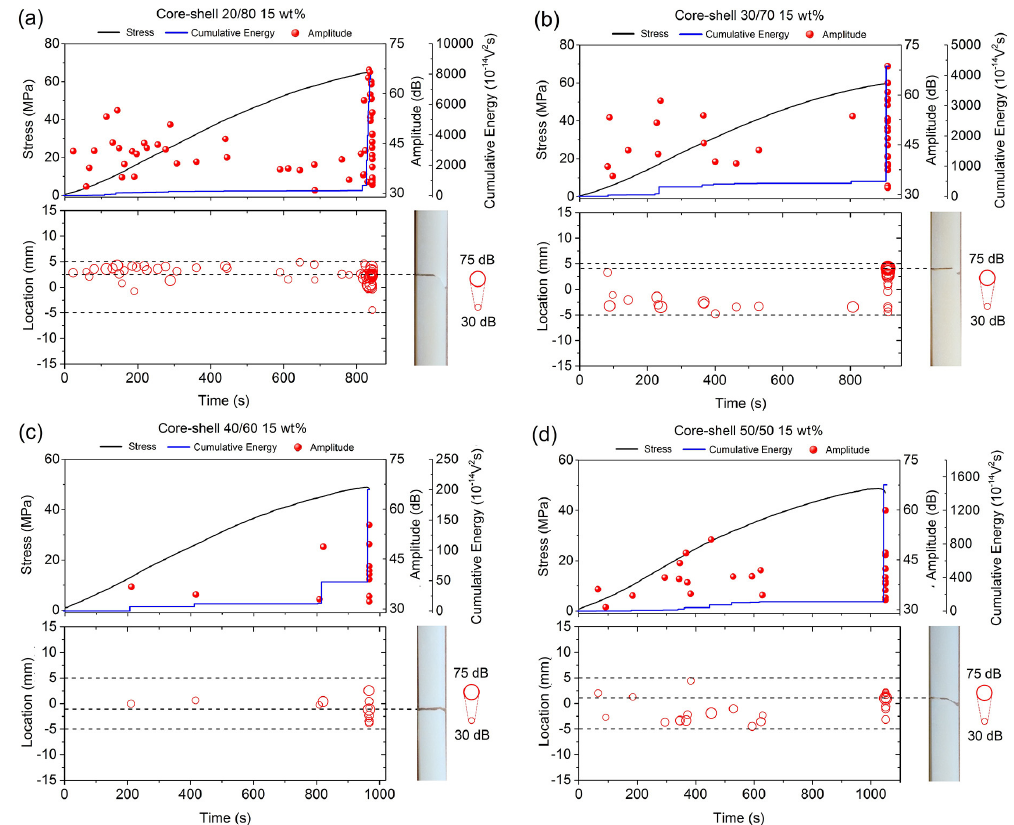
Figure 6. AE signals detected during the four-point bending test in correlation to their respective locations along the specimen surface in the bone cements containing 15 wt % of core-shell nanoparticles ( a ) 20/80, ( b ) 30/70, ( c ) 40/60, and ( d ) 50/50.